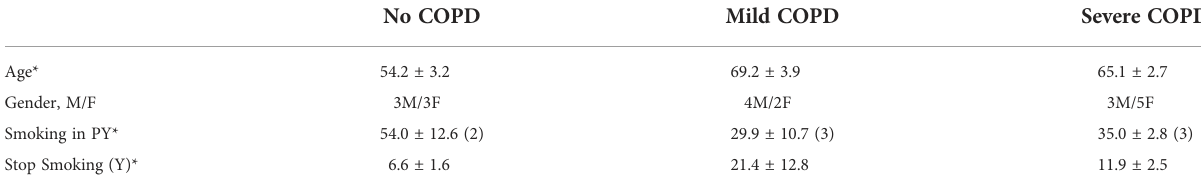
TABLE 1 Demographics of the study cohort of COPD patients with clinically-de fi ned GOLD stage severity and self-reported smoking